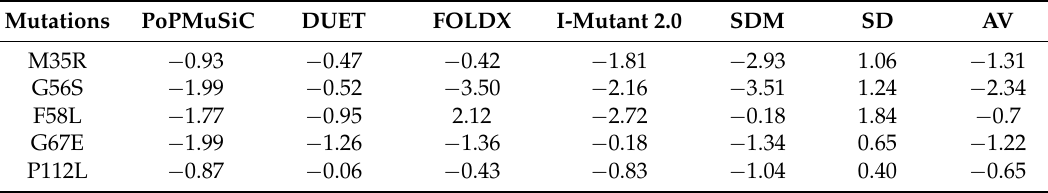
Table 1. Predictions of monomer stability change due to missense mutations. The calculated folding